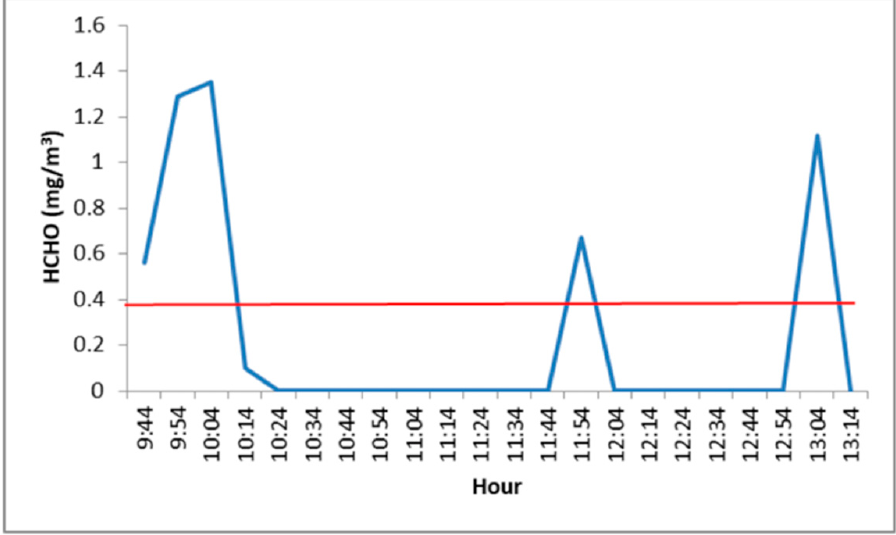
Figure 2. HCHO concentrations (mg/m 3 ) in the doctor’s consultation (Red line: Guideline Value). Indoor and outdoor sources can contribute to PM levels (PM 10 , PM 2.5 ). Indoor